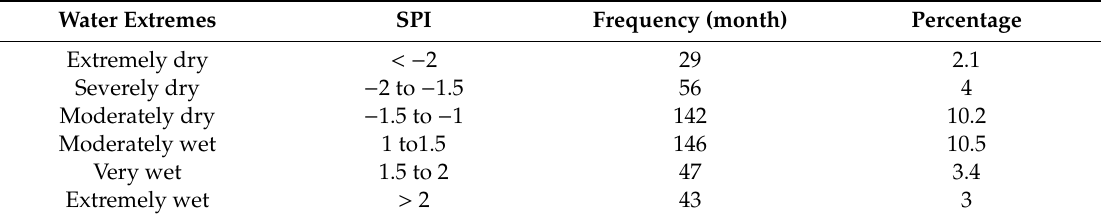
Table 1. Characterization of water extremes at the Santa Catalina stream basin through the use of the 12-month SPI.